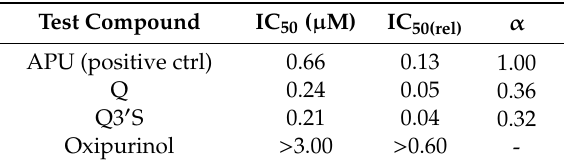
Figure 7. Inhibitory effects of quercetin (Q), quercetin-3 ′ -sulfate (Q3 ′ S), allopurinol (APU), and oxipurinol on XO-catalyzed oxidation of hypoxanthine (5 μ M) after 4 min incubations. The 50% inhibition of metabolite (xanthine + uric acid) formation (IC 50 ) is marked with dashed line (* p < 0.05, ** p < 0.01). Table 2. Inhibition of XO-catalyzed hypoxanthine oxidation by Q, Q3 ′ S, APU, and oxipurinol. IC 50 : concentration of the compound which induces 50% inhibition of metabolite formation, IC 50(rel) = IC 50 of the inhibitor divided by the substrate concentration (5 μ M hypoxanthine), α = IC 50 of the inhibitor divided by IC 50 of the positive control (APU).